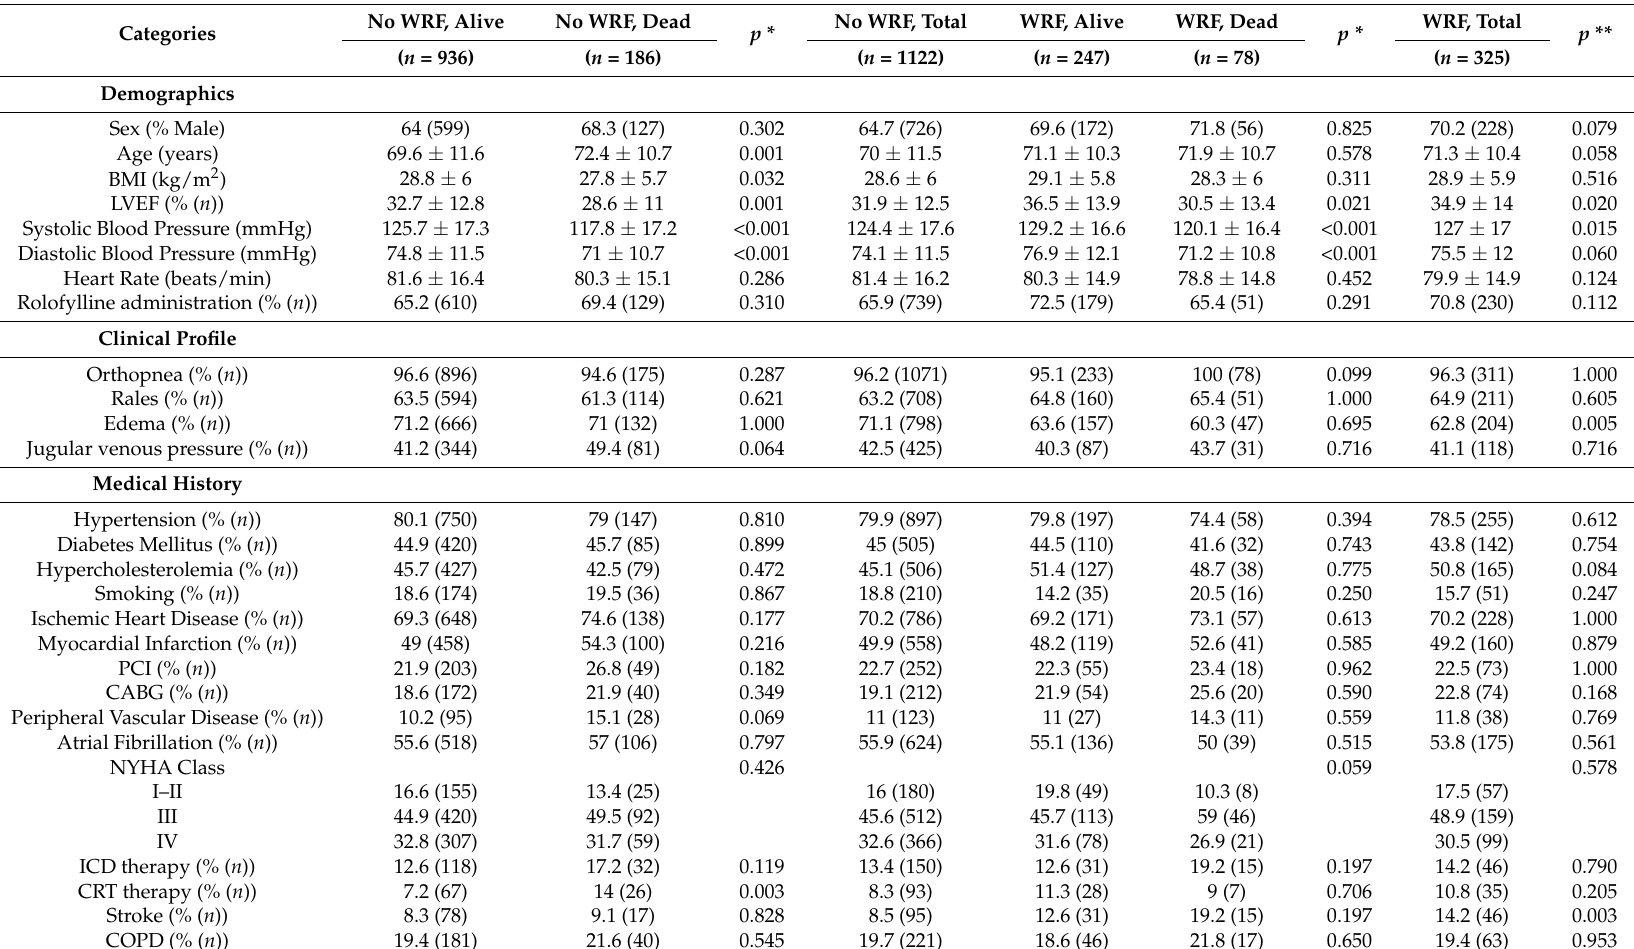
Table 1. Baseline characteristics for patients with and without worsening renal function (WRF), and by vital status, at day 180.